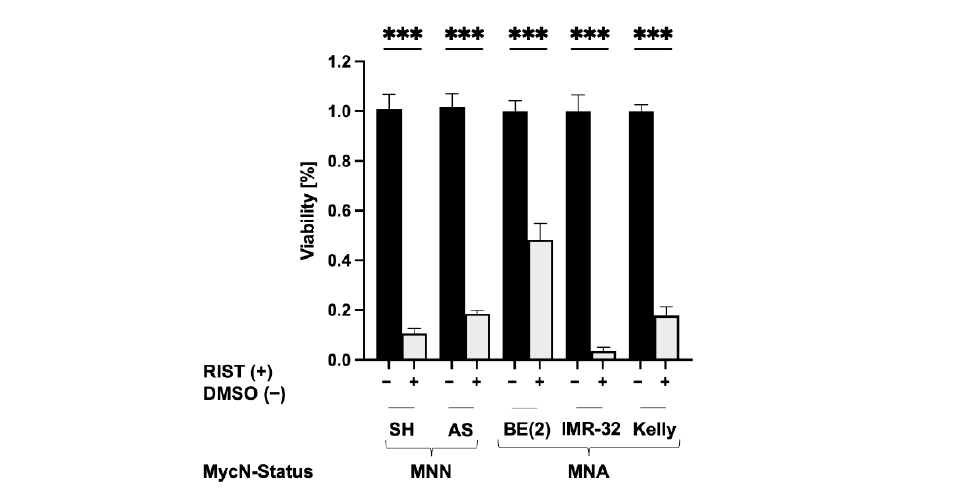
Figure 8. Viability of NB spheroids after RIST treatment. To determine the impact of the multimodal RIST treatment (Figure 4) on spheroid viability, spheroids were harvested on day 7 (complete RIST) and analyzed applying the CellTiter-Glo 3D Cell Viability Assay. NB cell lines: SK-N-SH (SH), SK-N-AS (AS), SK-N-BE(2) (BE(2)), IMR-32 and Kelly. RIST (+) or DMSO ( − ) (vehicle)